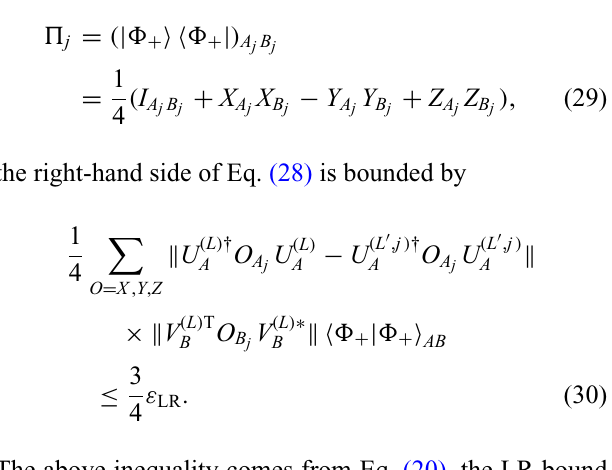
} θ θ (cid:16) , i , k so that i , k and i , k i , k